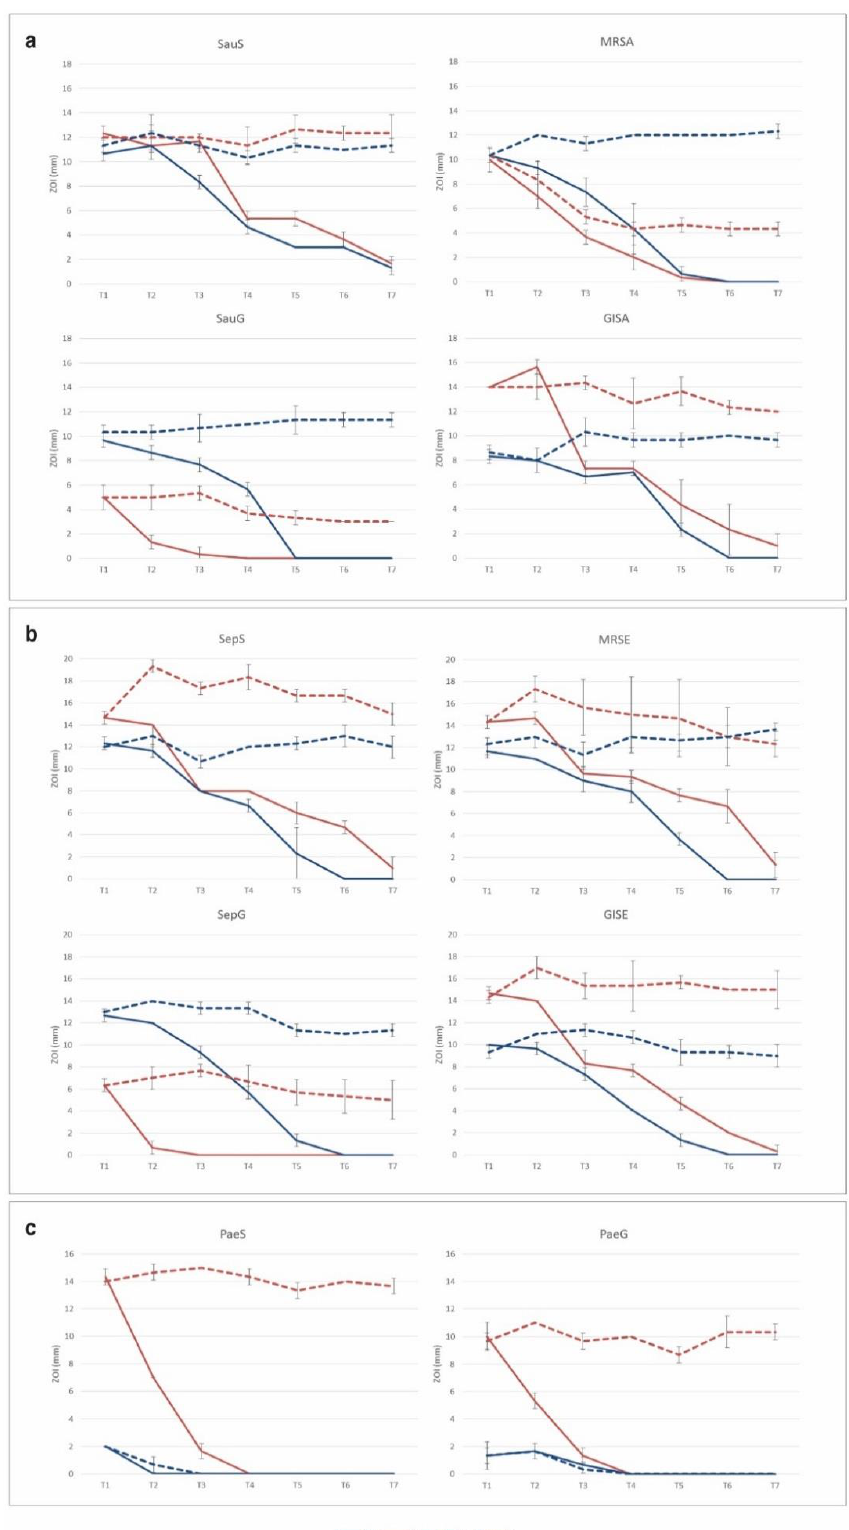
Figure 6. Zone of inhibition (ZOI) of ( a ) Staphylococcus aureus , ( b ) Staphylococcus epidermidis and ( c ) Pseudomonas aeruginosa growth on agar plates before (T0) and after (T7) exposure to CG/CV. ZOI (mm ± SD) are plotted against time (days). (=), exposure to the same CG/CV disc; (≠), exposure to a fresh CG/CV disc.